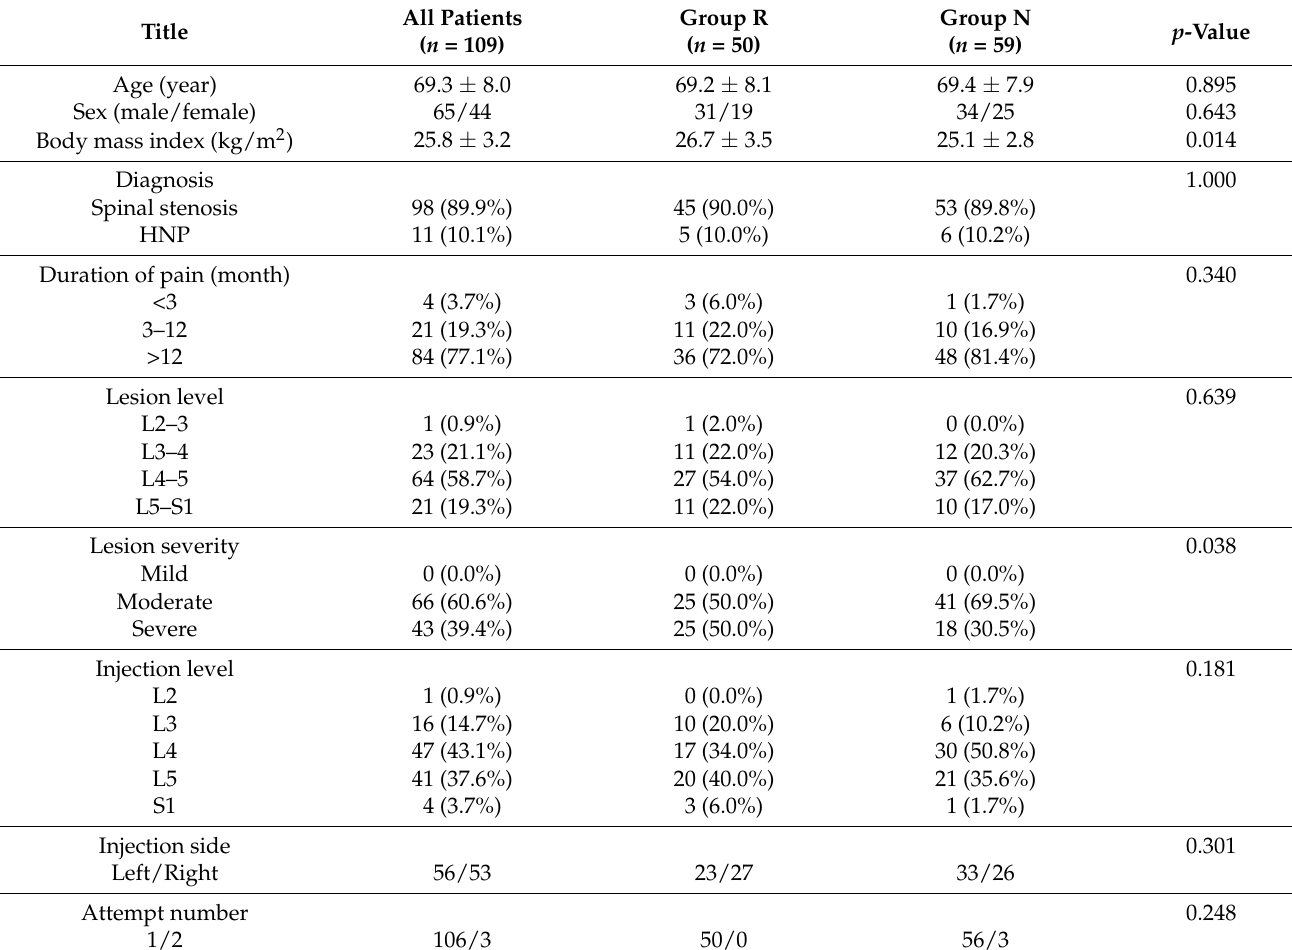
Figure 1. Flow diagram of the study. NRS: numerical rating scale. Table 1. Demographic and clinical